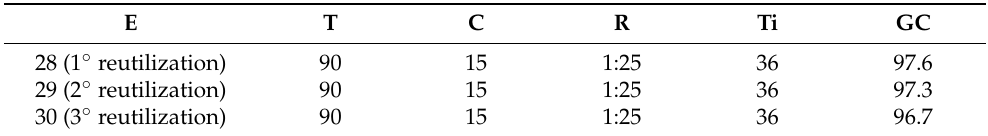
Table 12. Reutilization of Oligocat P24S in biodiesel synthesis.